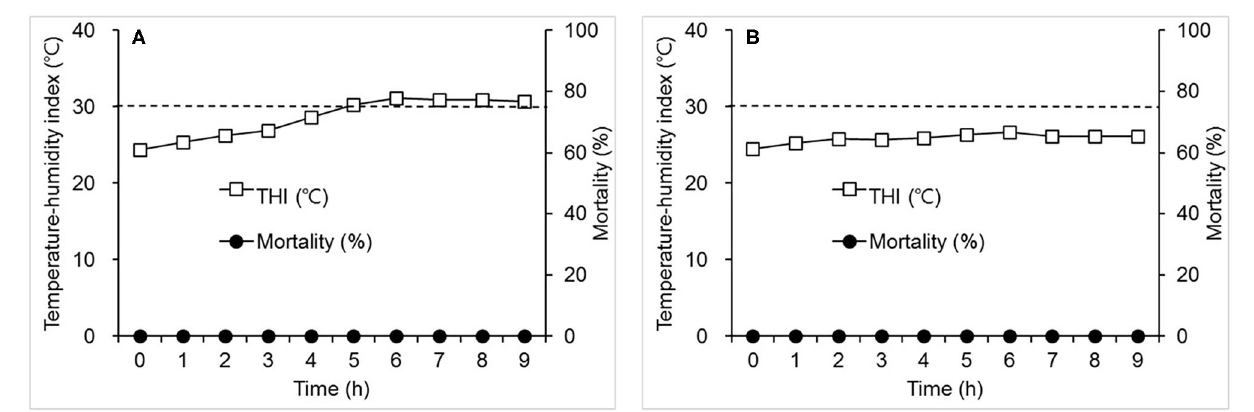
FIGURE 2 | The effects of a moderate increase in temperature-humidity index (THI) ( ◦ C) on mortality (%) in laying hens. Hens were exposed to one of the two following THI conditions for 9h. (A) THI: 24.3–31.2; dry-bulb temperature (Tdb) ( ◦ C): 27.0–35.5; web-bulb temperature (Twb) ( ◦ C): 20.4–25.3; and relative humidity (RH) (%): 55–37. (B) THI: 24.4–26.6; Tdb: 27.1–30.3; Twb: 20.5–21.3; and RH: 55.0–39.0. Mortality was measured at the time points specified (h). The dot line indicates THI of 30 ◦ C. N = 24 for A and 12 for B.